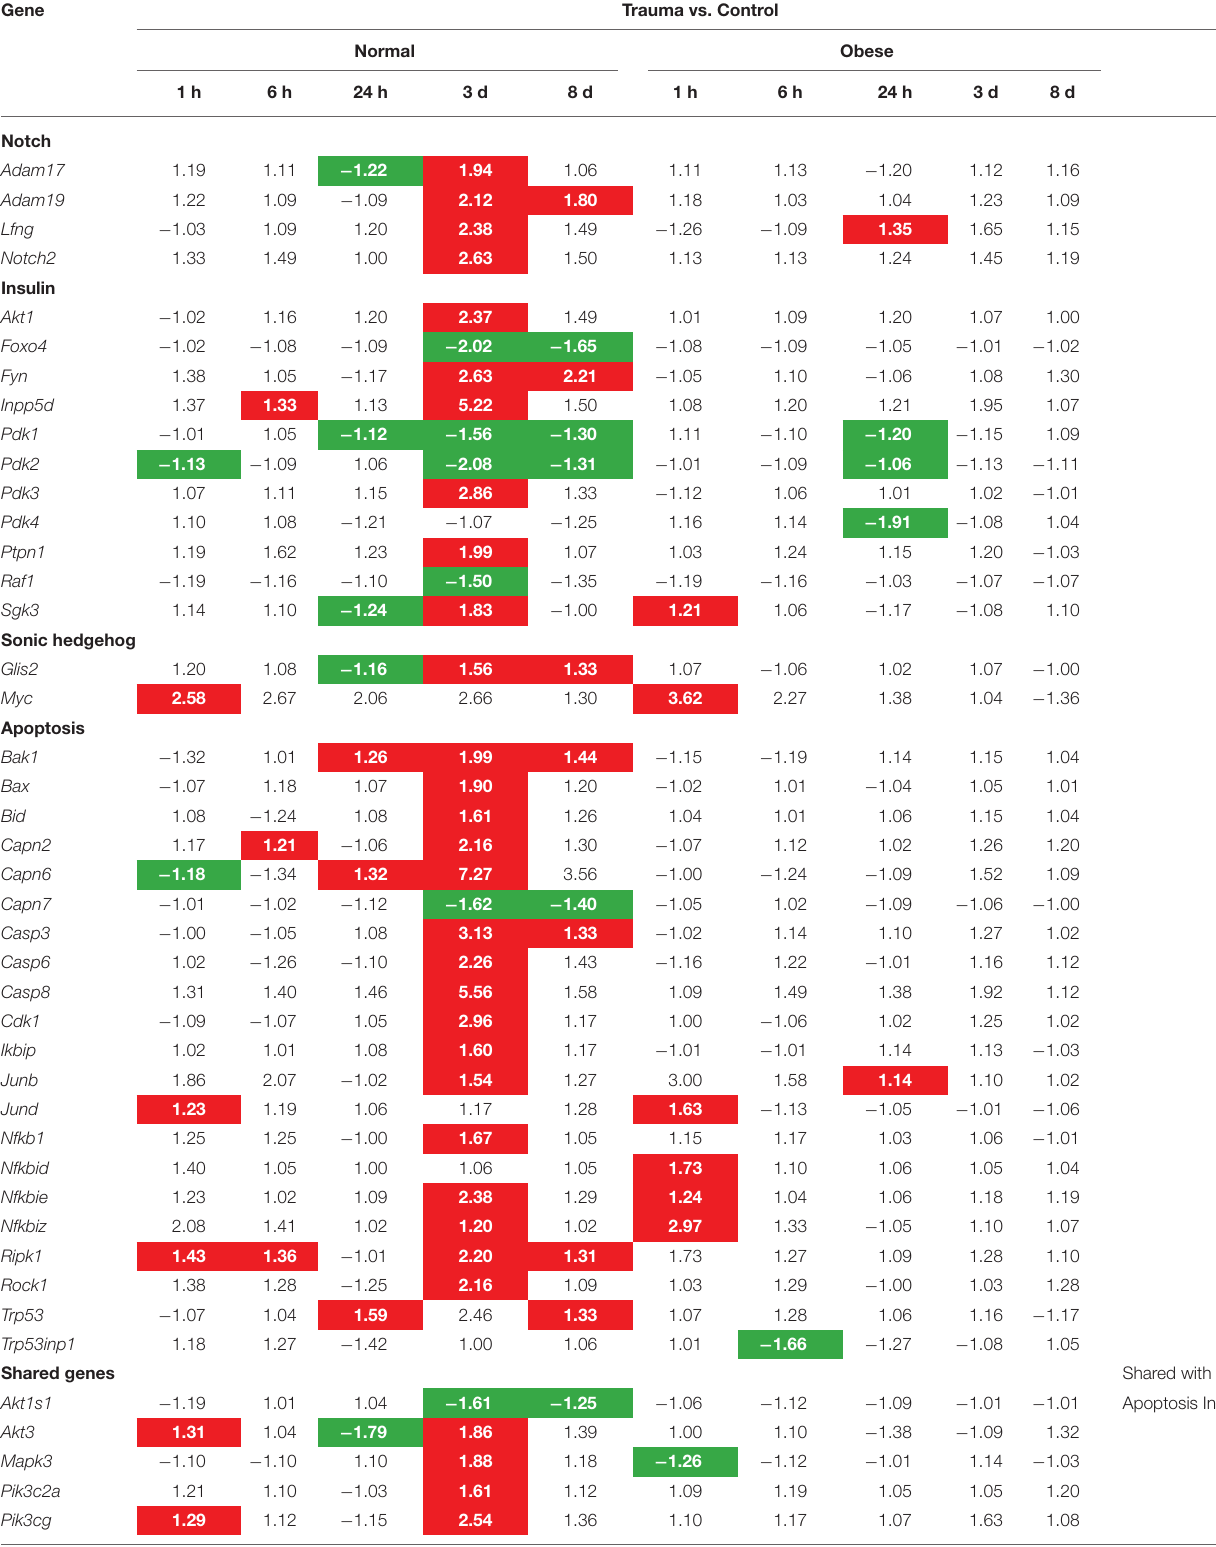
TABLE 7 | Expression levels of genes associated with notch, insulin, sonic hedgehog (Shh) and apoptosis. Gene Trauma vs. Control Normal